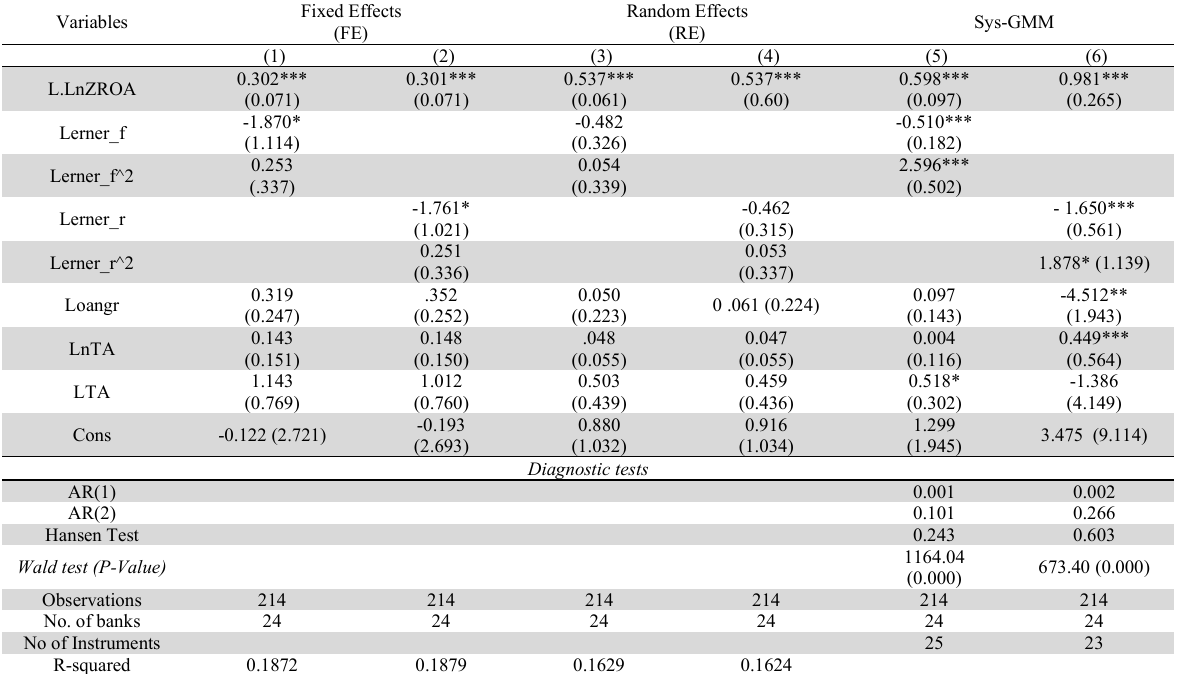
Estimation results for LnZROA as dependent variable